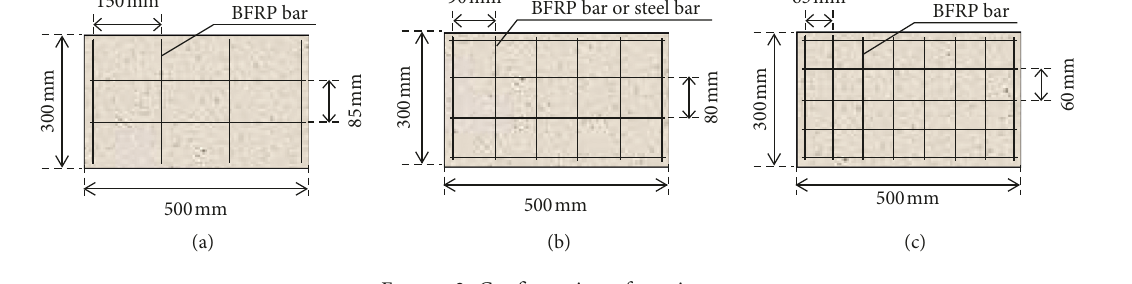
Figure 2: Configuration of specimens. Table 1: Specimens for the experiment.